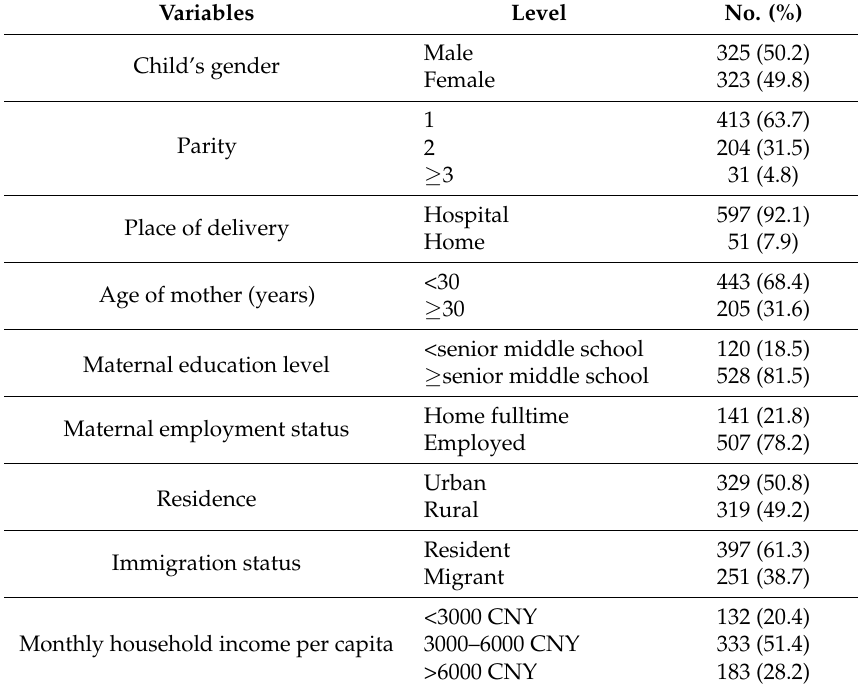
Table 2. Summary distribution of the characteristics of children aged 12–23 months ( N = 648).